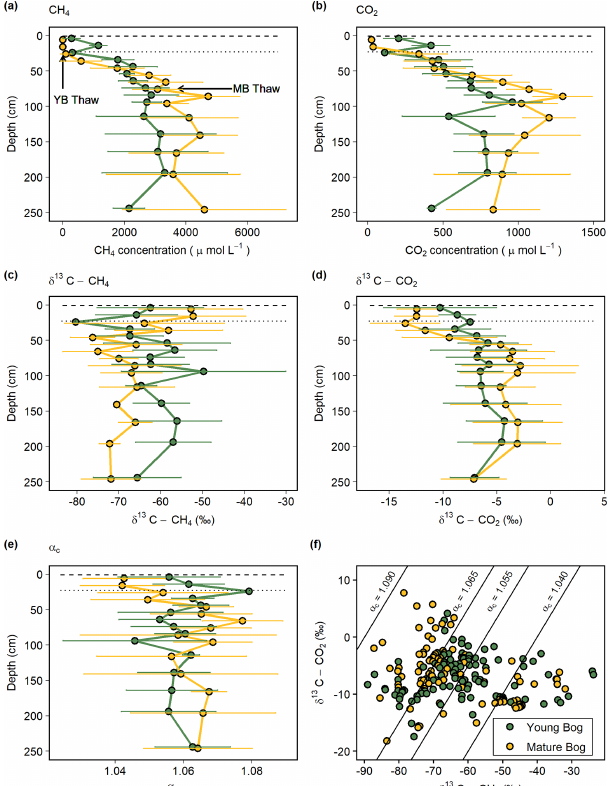
Figure 2. Average seasonal (May–September) depth profiles in the young (green, black circles) and mature (yellow, black circles) bogs of (a) dissolved CH 4 concentration (µmolL − 1 ), (b) dissolved CO 2 concentration (µmolL − 1 ), (c) δ 13 C-CH 4 (‰), (d) δ 13 C-CO 2 (‰), and (e) apparent fractionation factor ( α c ) between dissolved CH 4 and CO 2 . (f) Cross-plot of corresponding δ 13 C-CH 4 and δ 13 C-CO 2 values (‰) in the young bog and mature bog from raw data used in panels (c) and (d) . Diagonal lines represent different α c , where α c 1.040–1.065 represents acetoclastic methanogenesis, and α c 1.055– 1.09 represents hydrogenotrophic methanogenesis (Whiticar, 1999). (a–e) Dashed and dotted horizontal lines represent water table depth in the young bog (YB) and mature bog (MB), respectively. Arrows in panel (a) represent depth of thaw transition in both the young bog (29cm) and mature bog (71cm), i.e., the transition from deep peat (accumulated prior to thawing) and shallow peat (accumulated